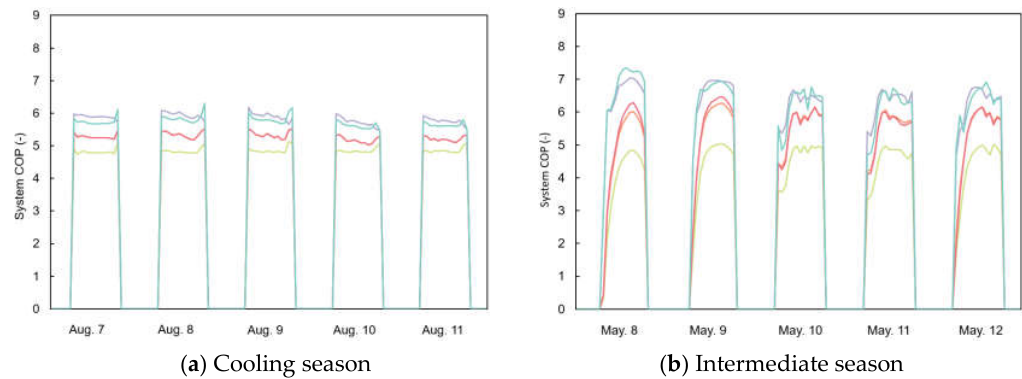
Figure 15. Weekly system COP for Case A–E.